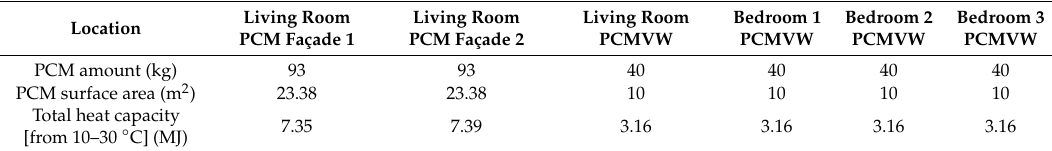
Table 2. The PCM amount for each room.